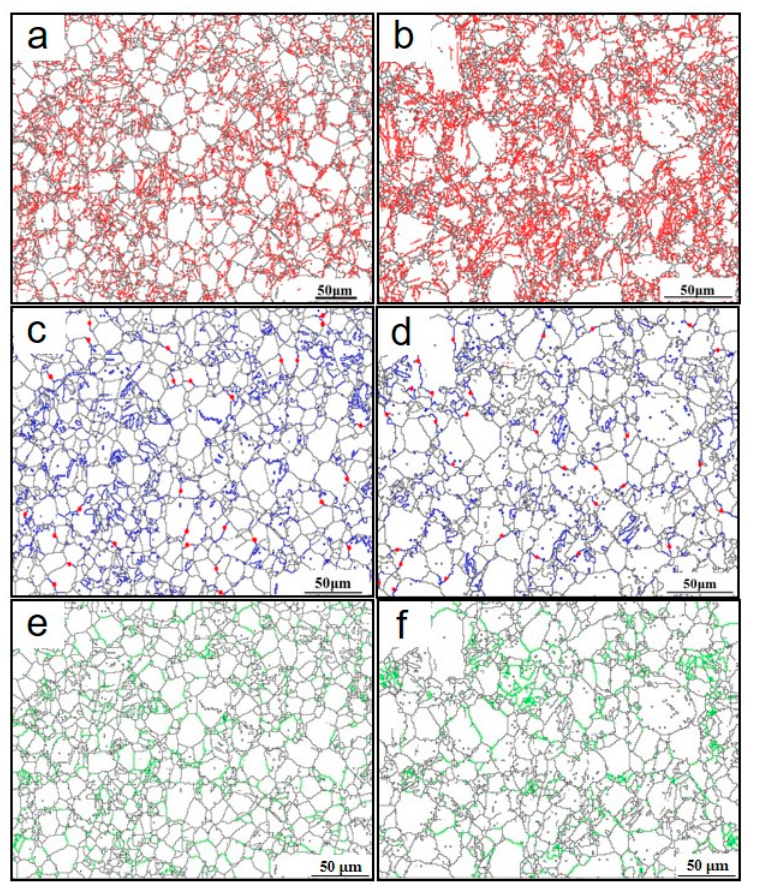
Figure 5. Misorientation distributions of various samples: ( a ) F-7; ( b ) F-12.